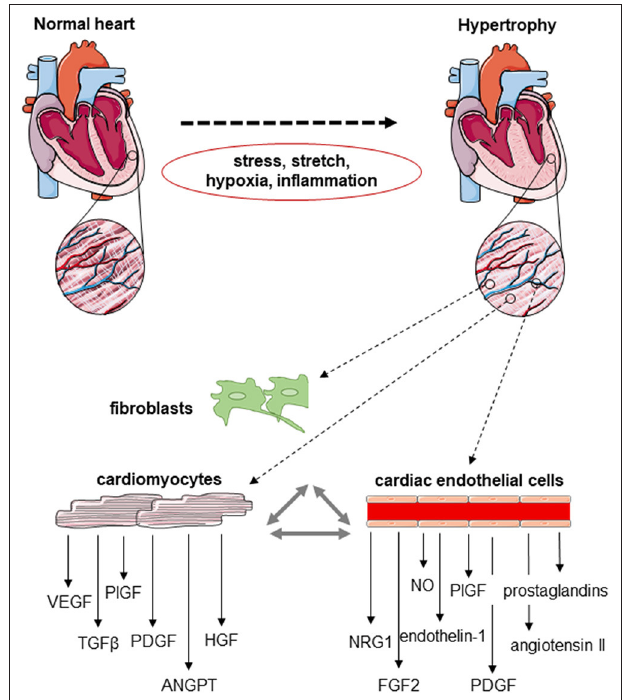
FIGURE 1 | Schematic drawing of the cardiomyocyte–endothelial cell cross-talk during cardiac angiogenesis. Cardiomyocytes, fibroblasts and cardiac endothelial cells express a number of factors known to be involved in the regulation of endothelial cell proliferation, migration and new vessel formation, but also cardiomyocyte growth and contractility. The expression of these mediators of the endothelial–cardiomyocyte cross-talk changes in response to hemodynamic stress, mechanical stretch, hypoxia, and/or inflammation developing during cardiac